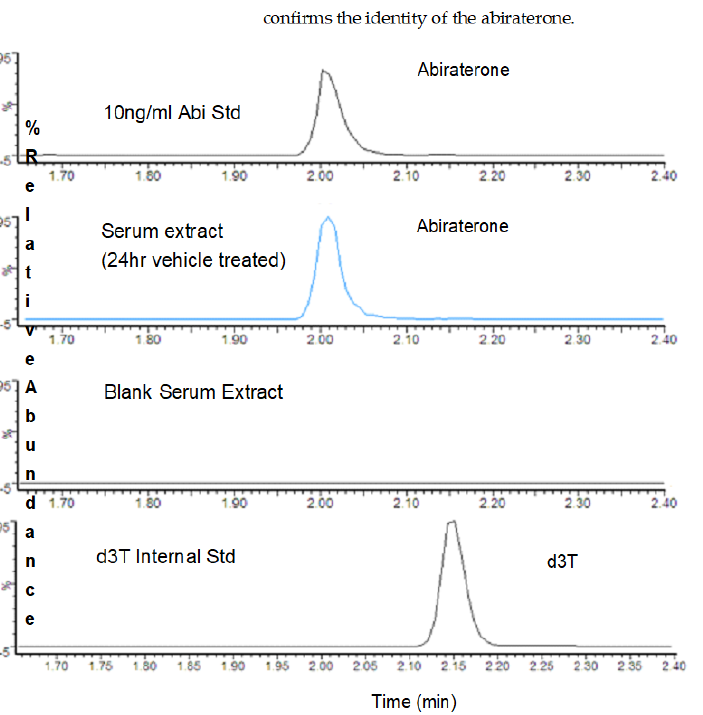
Figure 2. Representative LC/MS chromatogram showing abiraterone and deuterated testosterone internal standard. Chromatograms were obtained either from the standard solutions were from serum extracted samples as indicated in the labels.